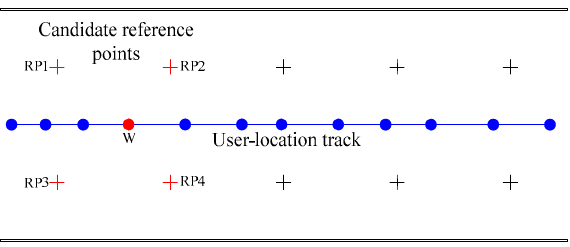
Figure 3. User-location track point and its corresponding candidate reference points.